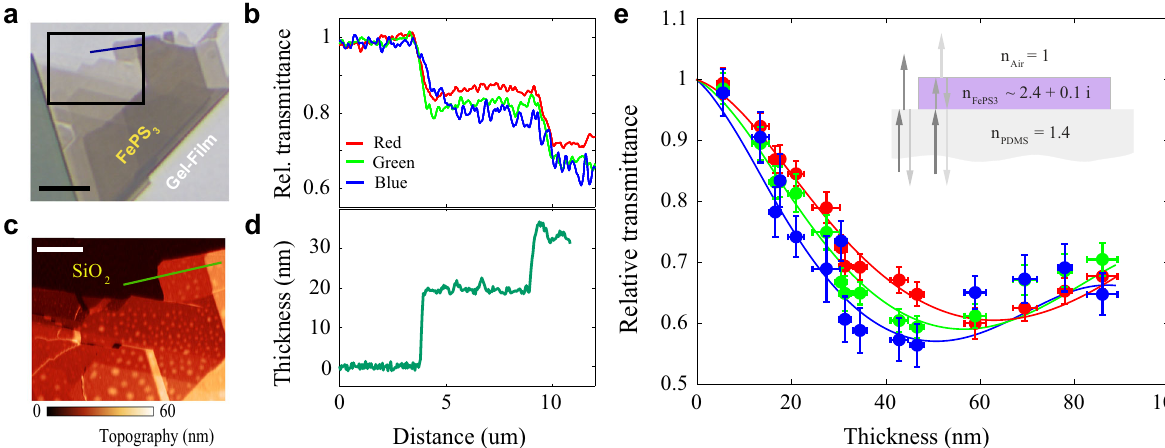
Fig. 1 Transmittance and thickness characterization. a White-light optical transmission image of a FePS 3 fl ake deposited onto a transparent polymeric substrate. The black scale bar represents 10 μ m. The fl ake appears quartered in stairs or terraces which correspond to different material thicknesses and appear as different value steps in the b transmission intensity line pro fi les for the red, green, and blue channels of the CMOS camera, normalized to the corresponding transmission intensities at the bare substrate (relative transmission) along the path marked as a dark blue line in ( a ). c AFM topography image of a small section of the fl ake shown in ( a ) after its deposition onto a SiO 2 /Si substrate. The white scale bar indicates 5 μ m. d Thickness pro fi le along the path marked with a green line in ( c ). e Relative transmittance versus thickness of FePS 3 nanosheets extracted from the comparison of optical and AFM characterization data for several fl akes. The red, green, and blue dots correspond to the experimental data points for the corresponding RGB channels, whereas the red, green, and blue line curves are the simulated results from the transfer-matrix model (sketched in the